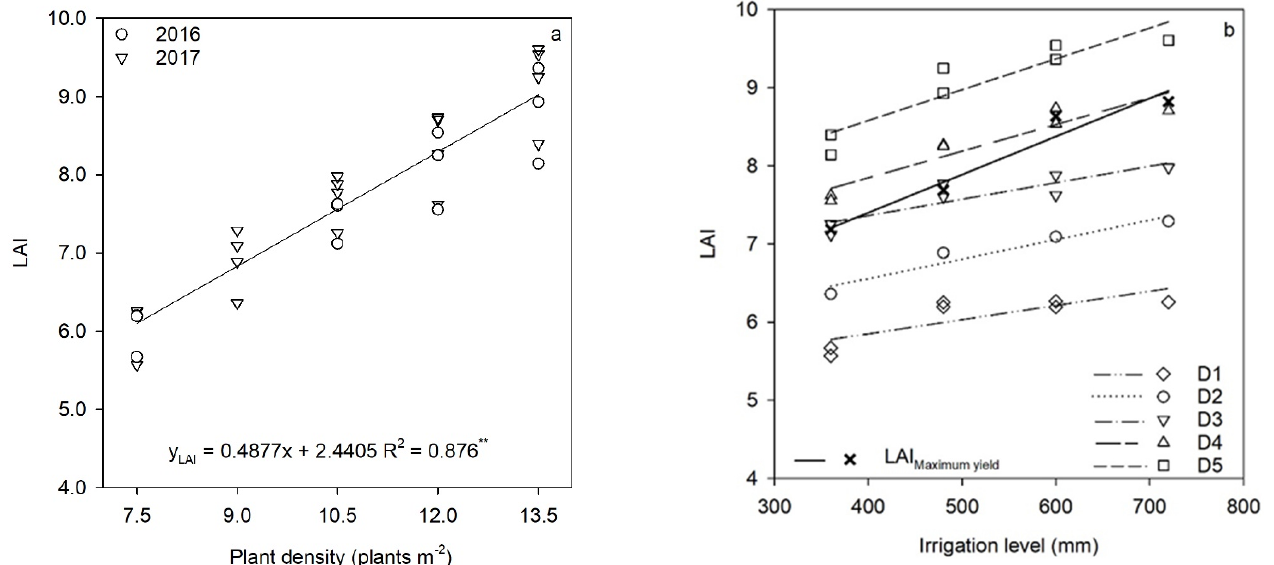
Figure 3. Relationships between the leaf area index (LAI) (silking) and planting density ( a ), LAI and irrigation level ( b ) in 2016 and 2017. D1, D2, D3, D4, and D5 represent 7.5, 9.0, 10.5, 12.0, and 13.5 plants m − 2 , respectively. ** denotes significance at the 0.01